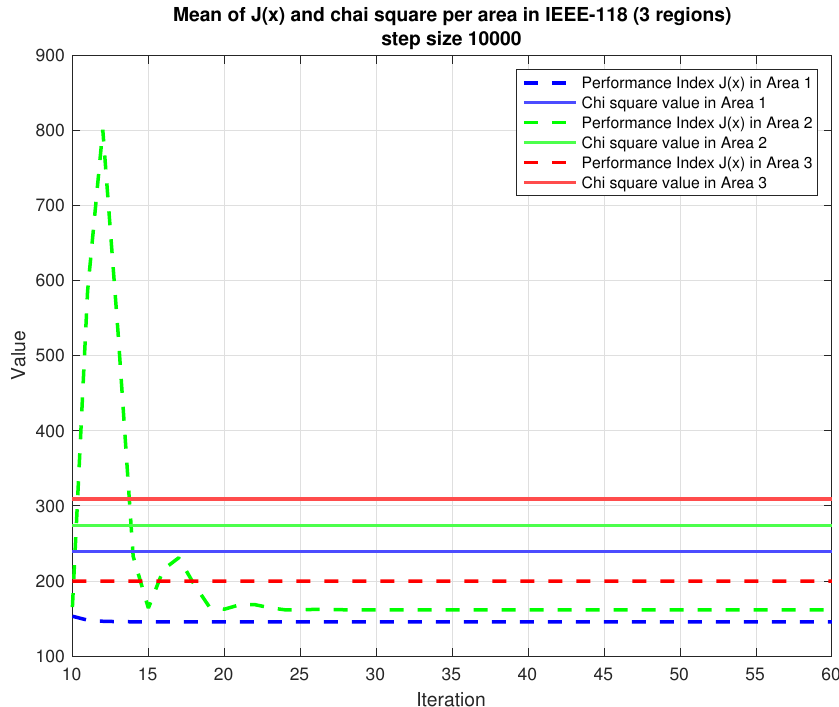
Figure 9. Per area mean of J(x) on the IEEE-118 bus system 3 regions.